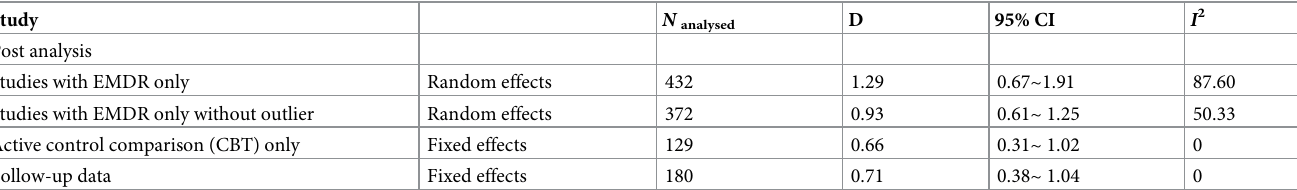
Summary results of all meta-analyses are shown in Table 3. Of the 11 studies, one did not report post-treatment data (follow-up data only). The remaining ten studies investigated the difference between a TFT and a control condition post-treatment totaling 559 participants. Two studies had three treatment groups, and two used two measures to assess depressive symptoms. As shown in Fig 2. the mean effect size was large [ d = 1.17 (95% CI: 0.58~ 1.75)]. Table 3. Meta-analysis of studies comparing the effects of trauma-focused treatments on depression.